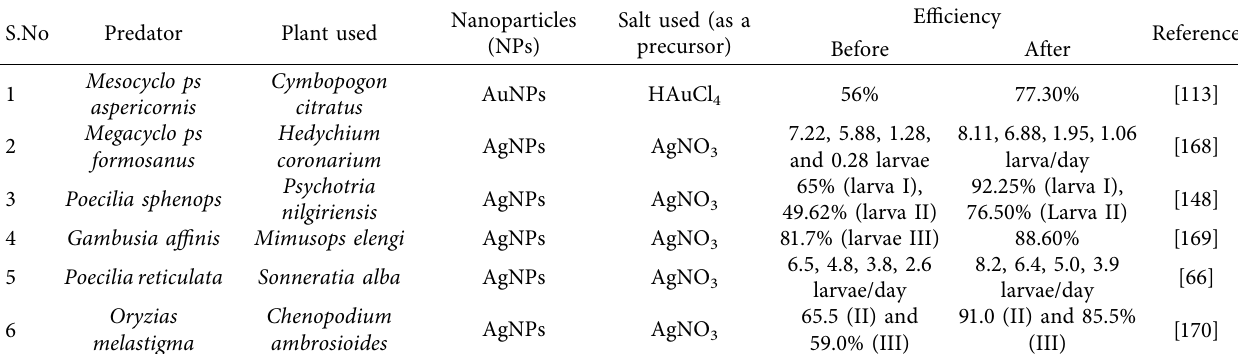
Table 2: Effect of NPs on the efficiency of predators of dengue